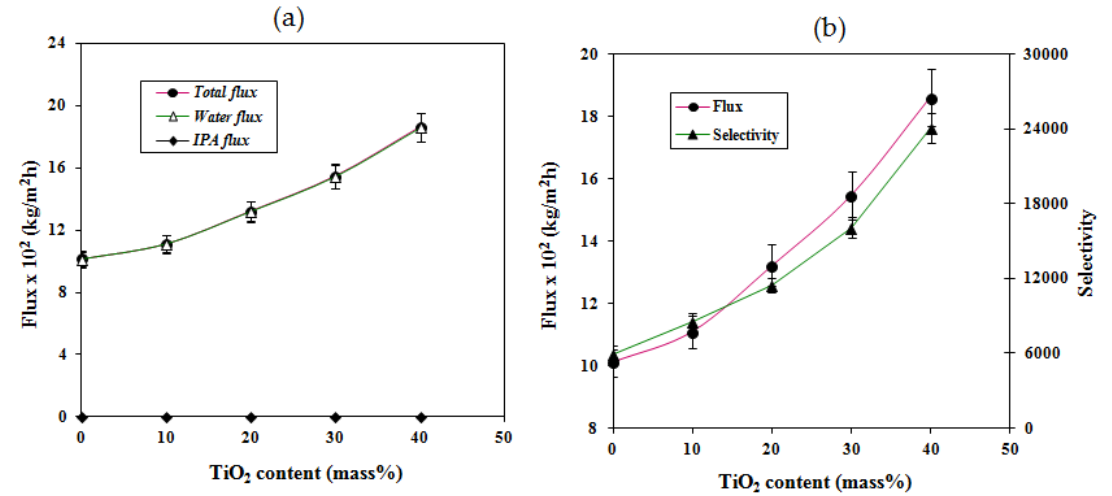
Figure 7. Variation of ( a ) flux and selectivity and ( b ) total flux and the fluxes of water and isopropanol with different percentages of TiO 2 in the membrane at 10 mass% of water in the